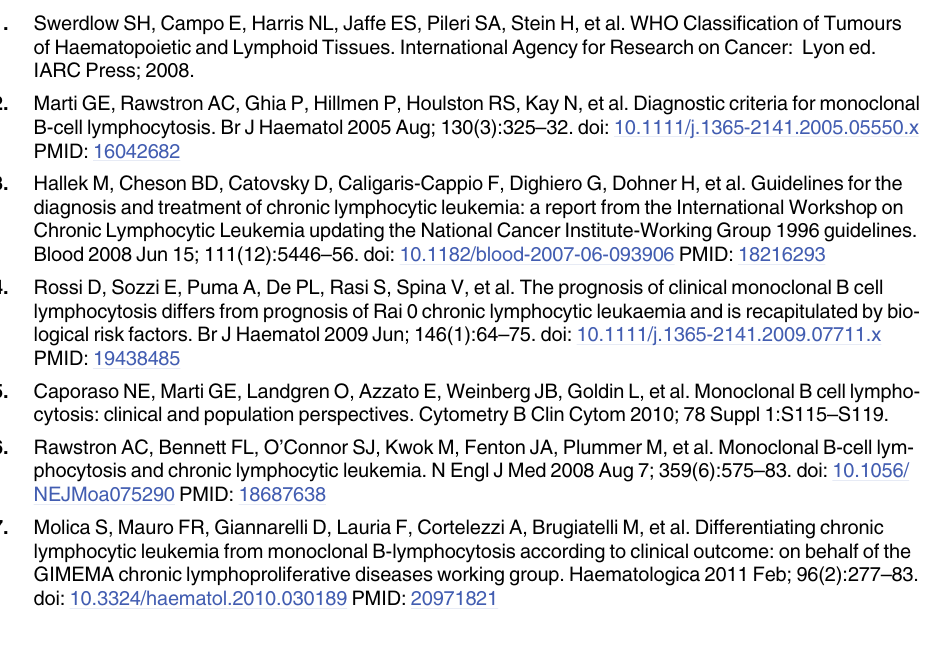
S5 Table. Biological and clinical characteristics of mutated (n = 180) and unmutated (n = 74) cases at